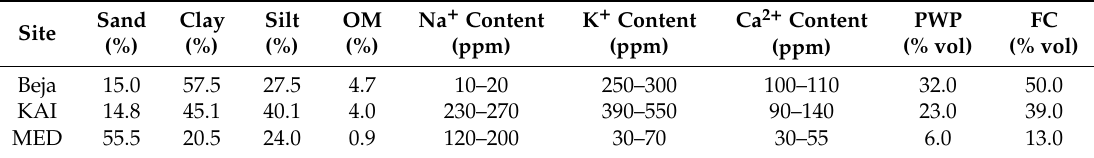
Table 2. Soil properties in three field trial